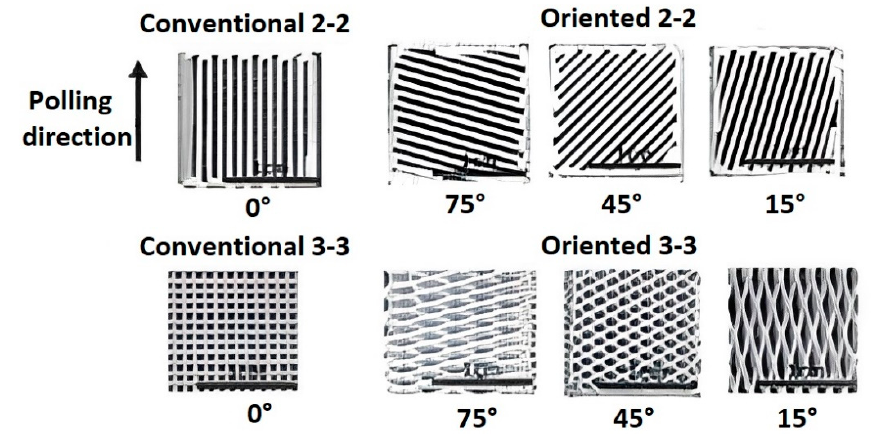
Figure 9. Oriented connectivity piezocomposites (2-2) and (3-3) printed by the FDM method (Reprinted from Ref. [74], copyright (2007), with the kind permission of Springer Science + Business Media LLC (New York, NY, USA, www.springer.com)).